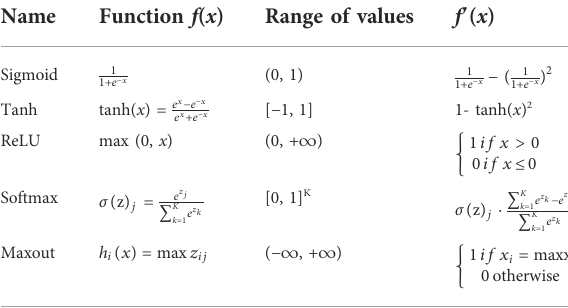
TABLE 2 Commonly used activation